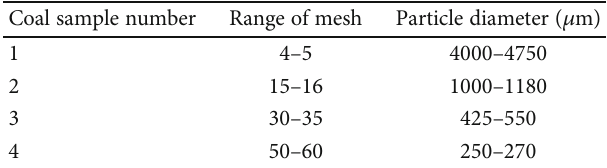
Figure 1: Coalbed structure of the di ff usion-seepage model of methane. Table 1: Particle dimension ( Φ ) of coal